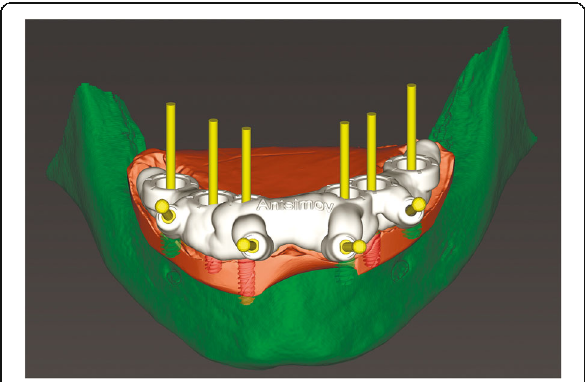
Fig. 3 Computer-aided design of surgical templates for fixating pins